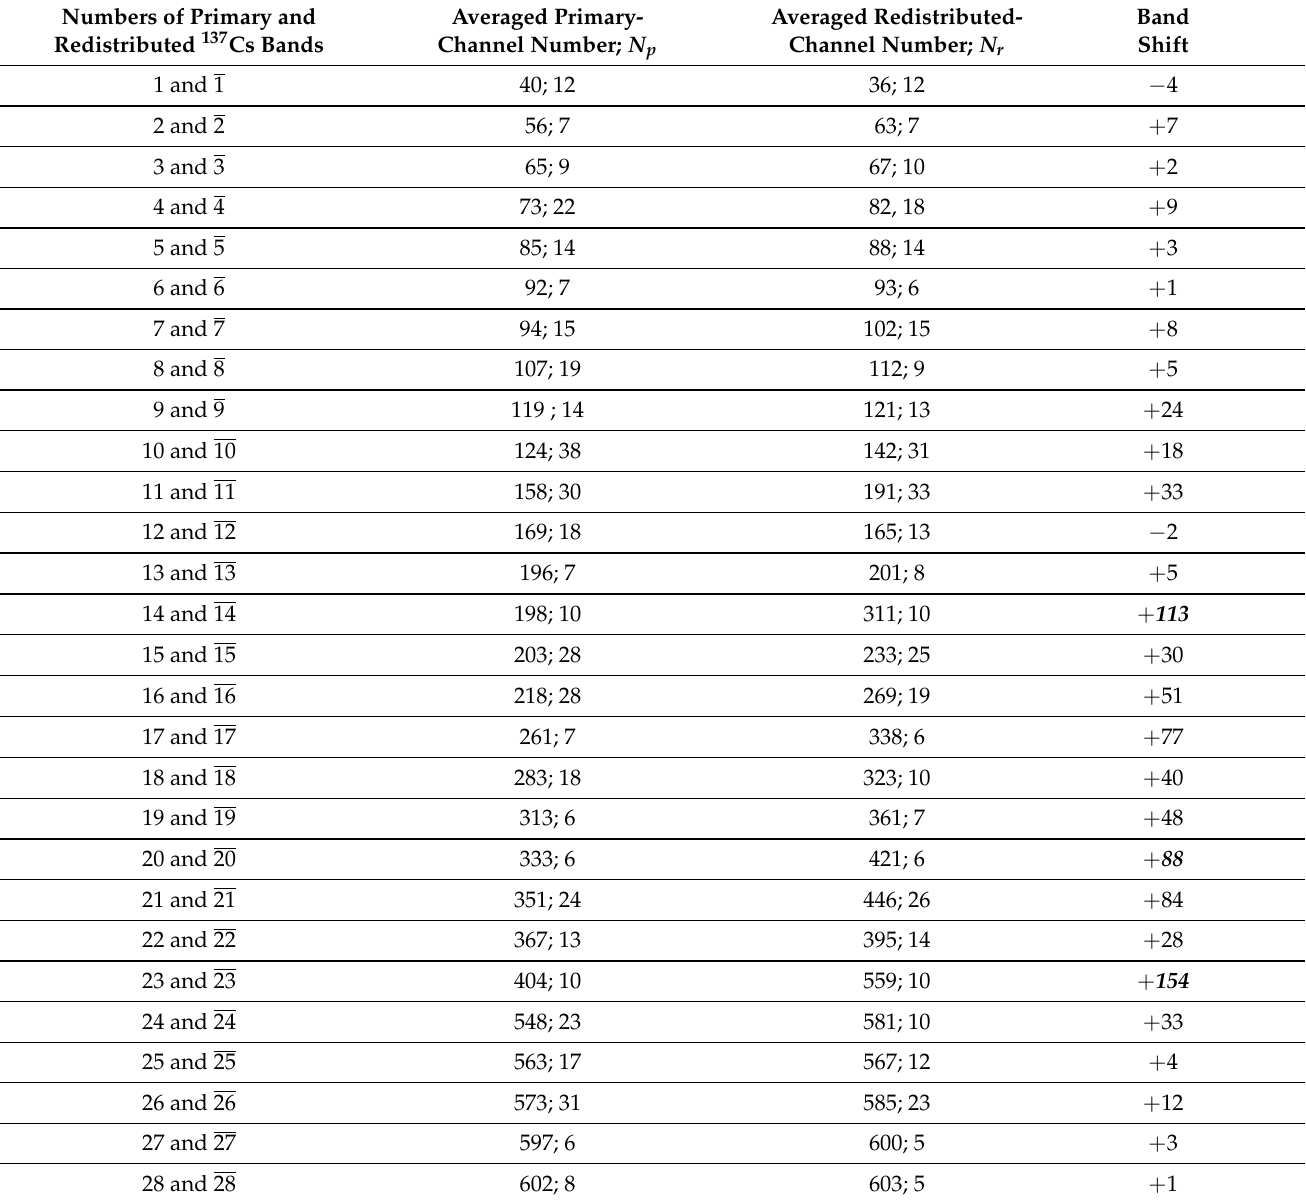
Table 2. Shifts in the 137 Cs-radiation spectrum bands in the presence of the bilayer absorber. Averaged numbers of events for the primary and redistributed bands are denoted by N p and N r ,